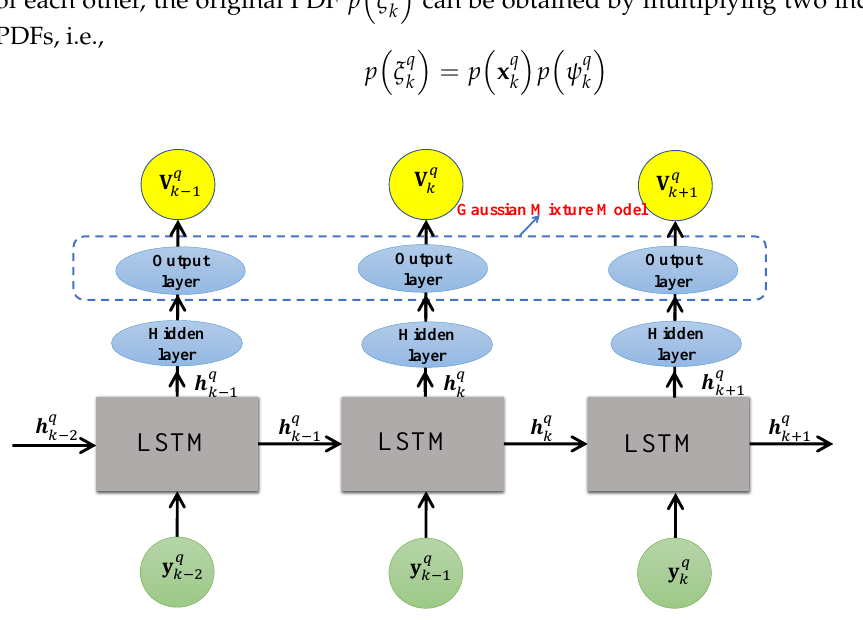
Figure 2. The prediction